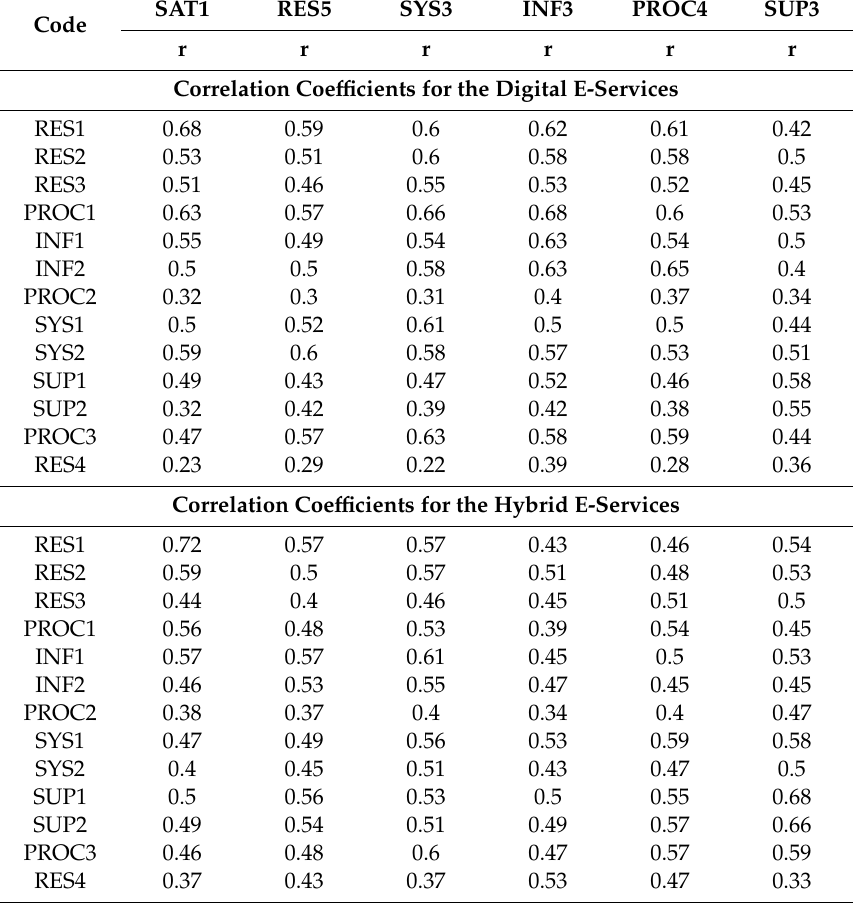
Table 8. Relationship between quality attributes of digital and hybrid